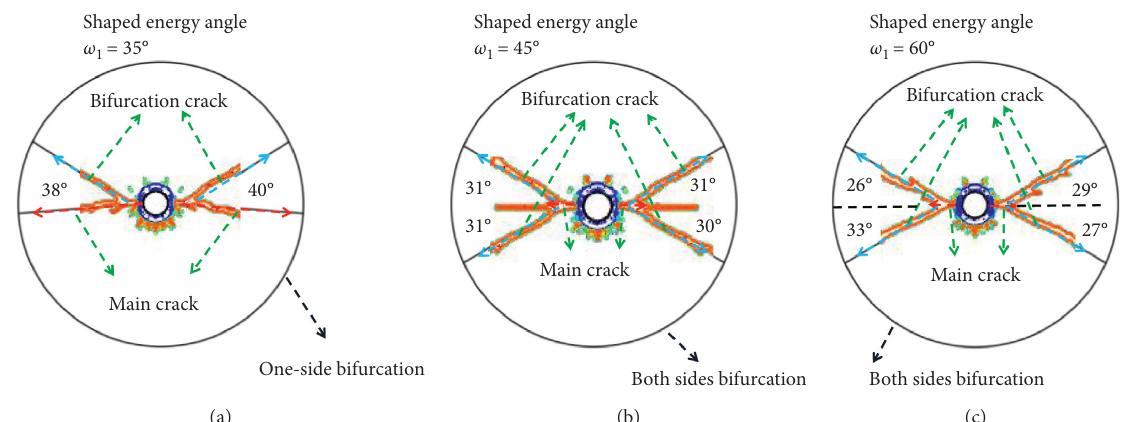
Figure 15: Schematic diagram of bifurcation of cracks at each angle.